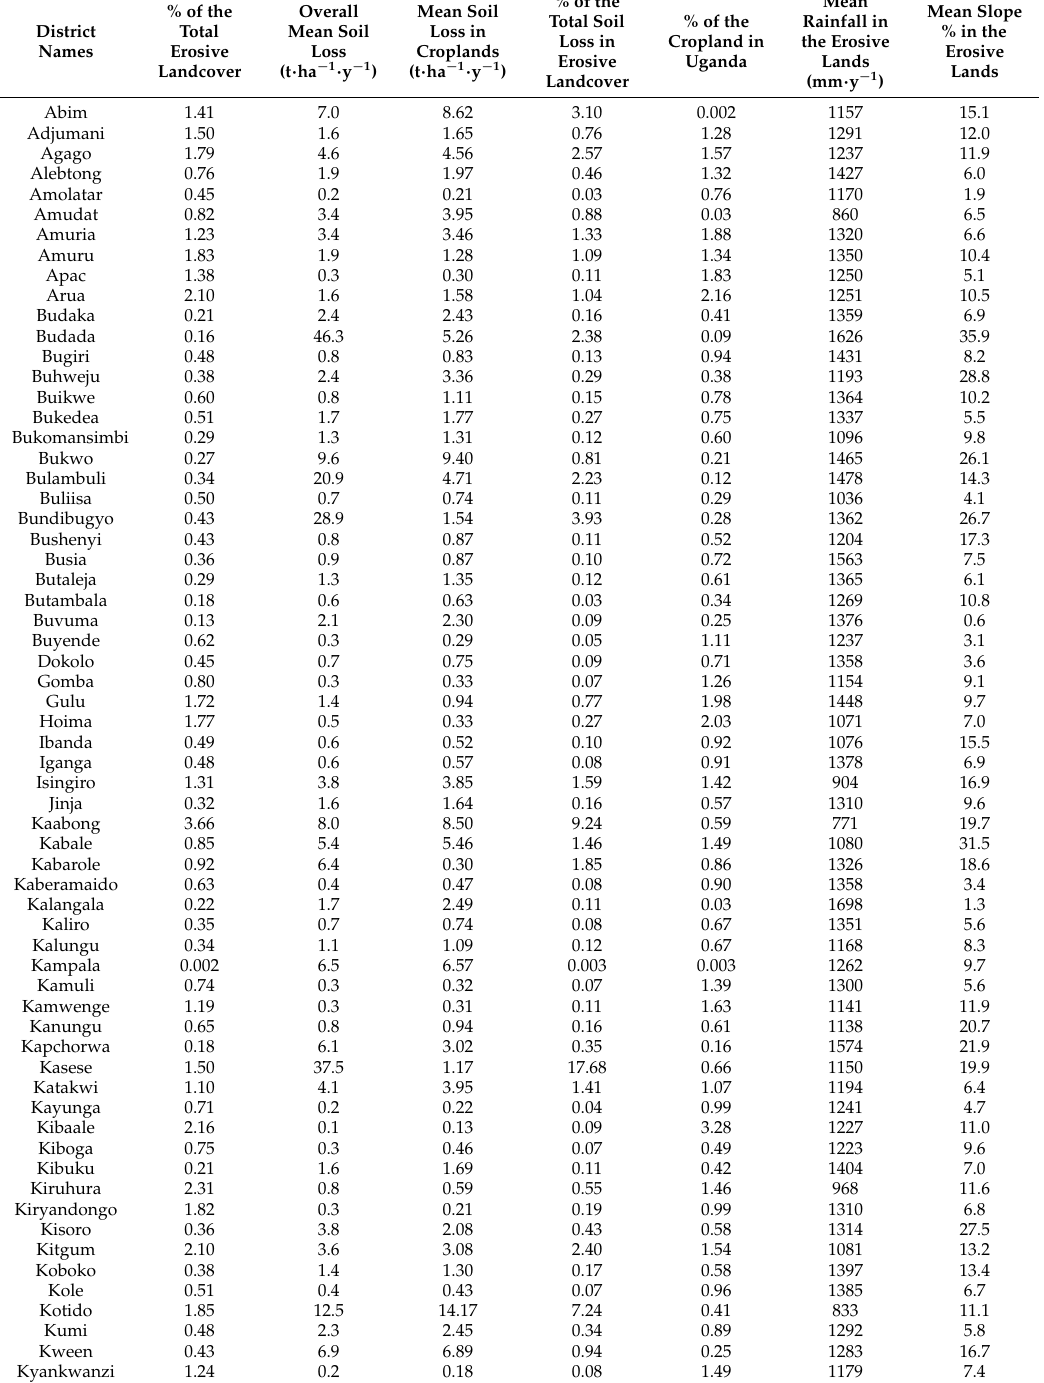
Table A1. Mean estimated soil loss rates per district (erosion prone lands, croplands), share of soil loss in the total erosion-prone lands, proportion of the total cropland, mean annual rainfall intensity and mean slope for the erosion-prone lands in Uganda